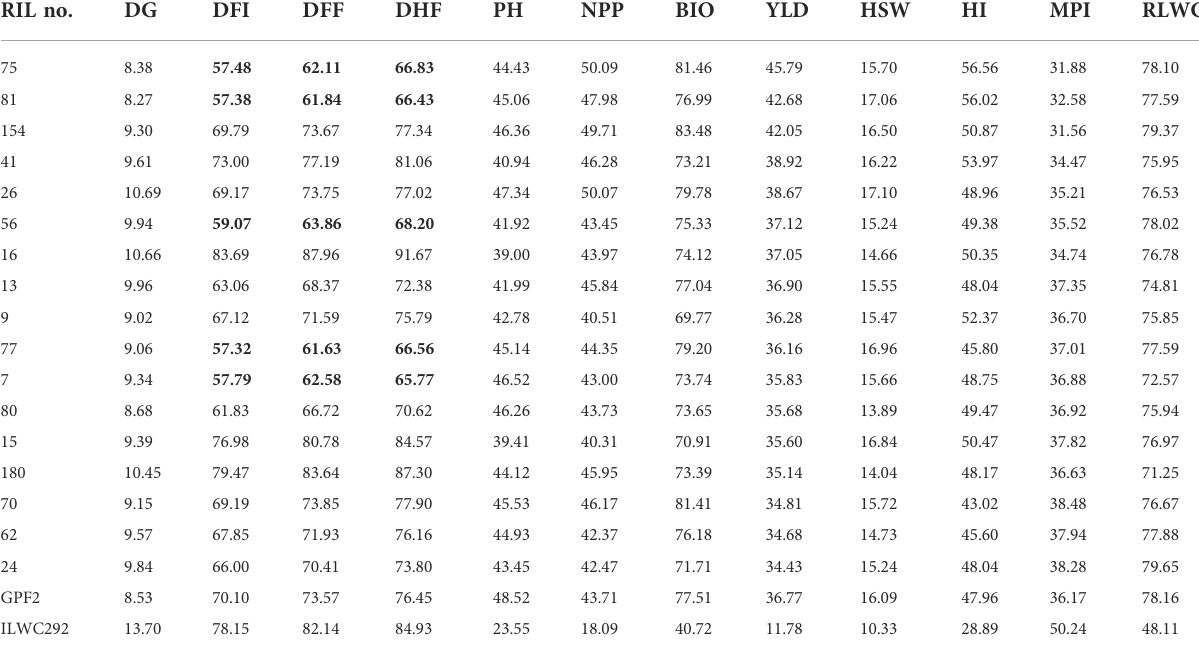
TABLE 3 List of promising recombinant inbred lines for various morphological and physiological traits under rainfed conditions (Ludhiana and Faridkot pooled). RIL